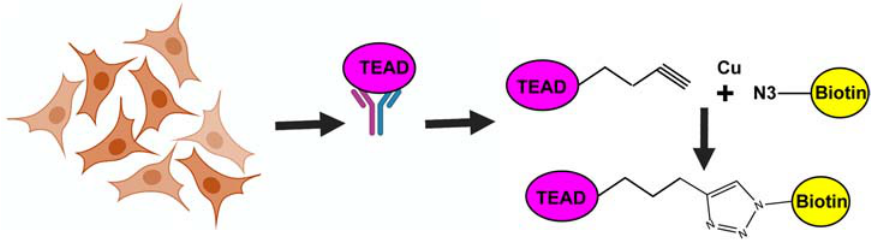
Figure 4. Schematic showing TEAD palmitoylation assay. Cells expressing TEAD are incubated with alkyne palmitate. Immunoprecipitated TEAD is covalently linked to biotin azide by click chemistry. Biotin is detected with fluorescently labeled streptavidin.